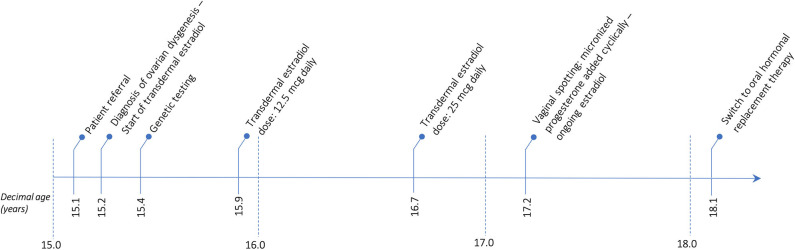
Timetable describing the sequence of the diagnostic and therapeutic interventions undertaken for the proband.